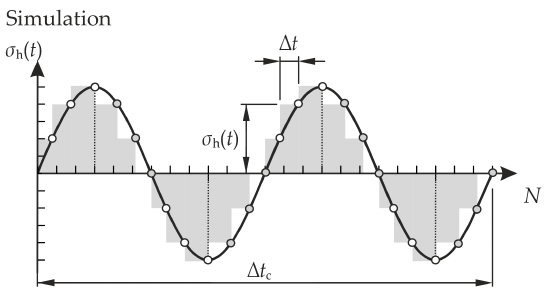
Figure 6. Approximation of the hydrostatic stresses σ h ( t ) in the diffusion